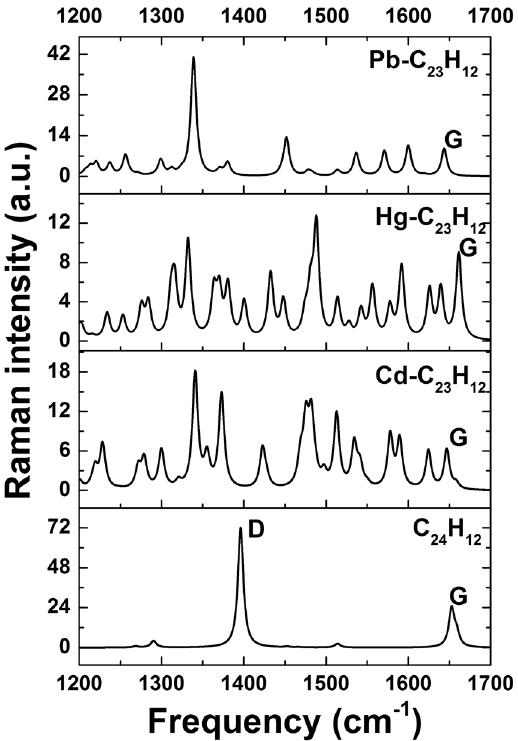
Figure 12. Raman spectra of the defective C 24 H 12 graphene quantum dots with and without different atoms of heavy